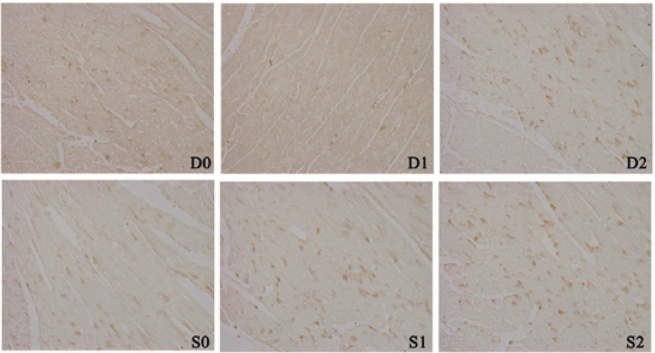
FIGURE 1 - TLR4 expression in the myocardium (200x). TLR4 expression in the myocardium increased in SHR over age (p<0.05: S0 vs S1; S0 vs S2). In the SHR undergoing RDN, the TLR4 expression was markedly lower than that in the rats of sham group (p<0.05: D1 vs S1; D2 vs S2).